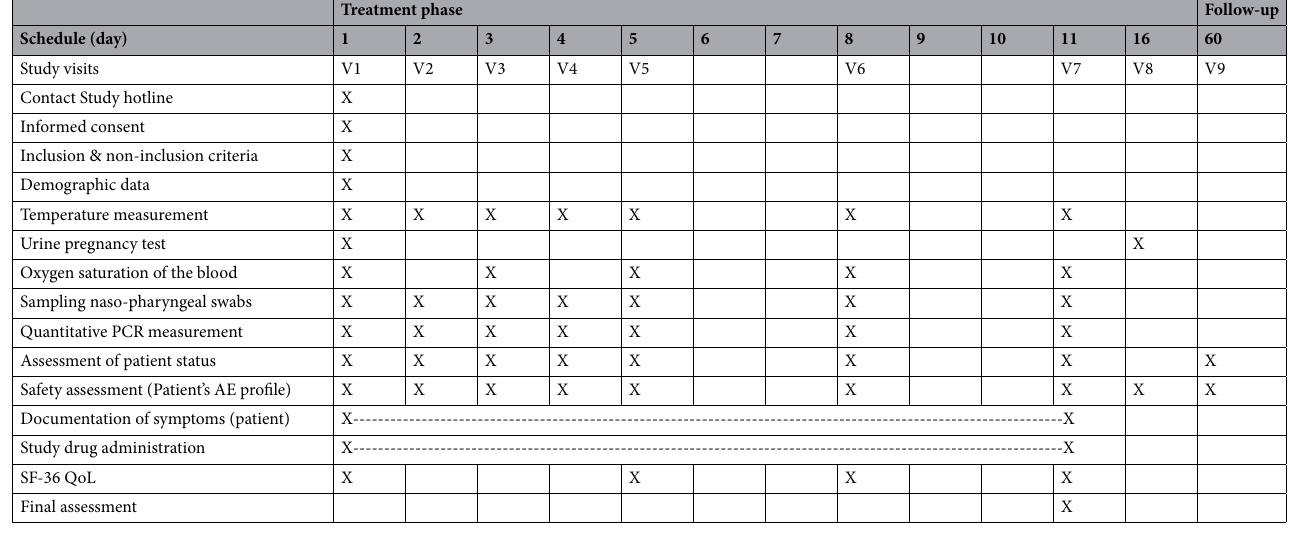
Table 2. Study flow